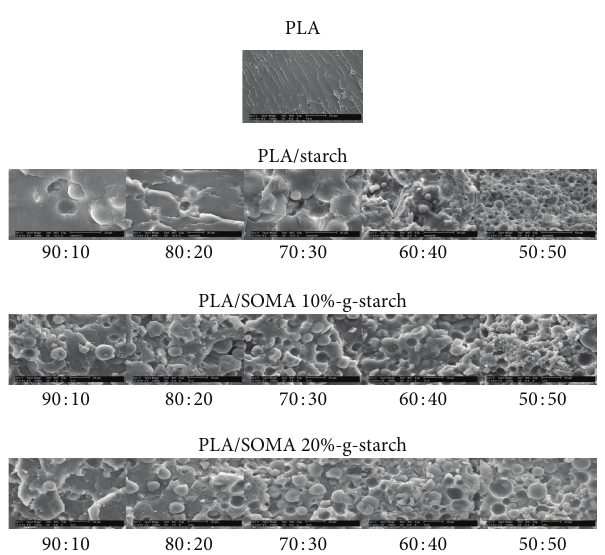
Figure 6: SEM images of PLA/Starch composites and PLA/SOMA- g-STARCH composites.